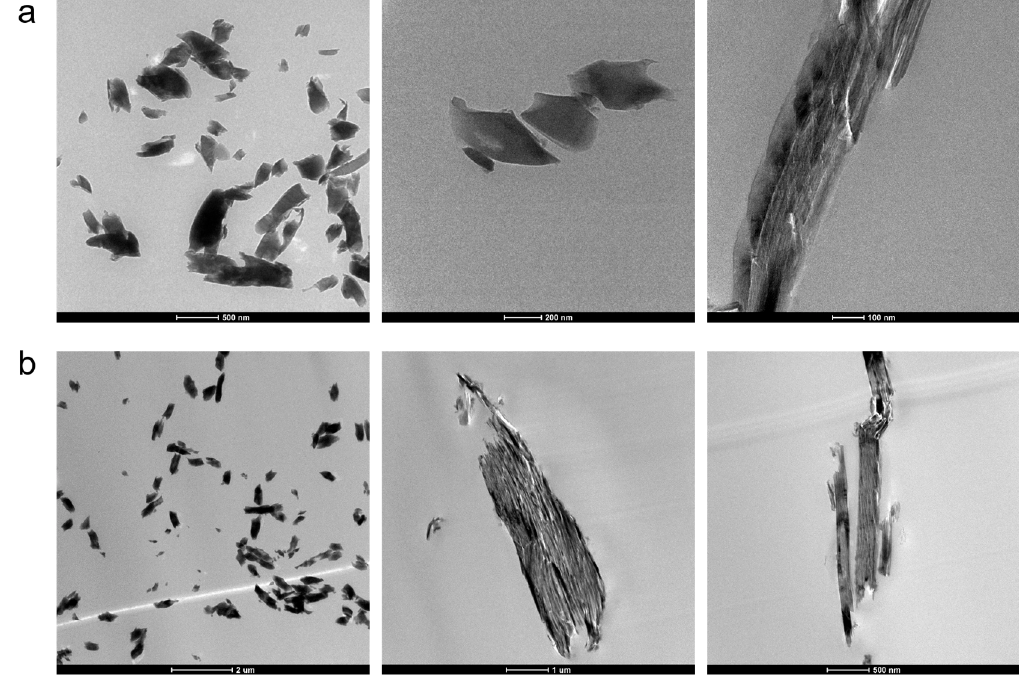
Figure 5. TEM micrographs of ( a ) the epoxy/mica nanocomposite EM10-5, and ( b ) the epoxy/mica nanocomposite EM45-5 at different magnifications.